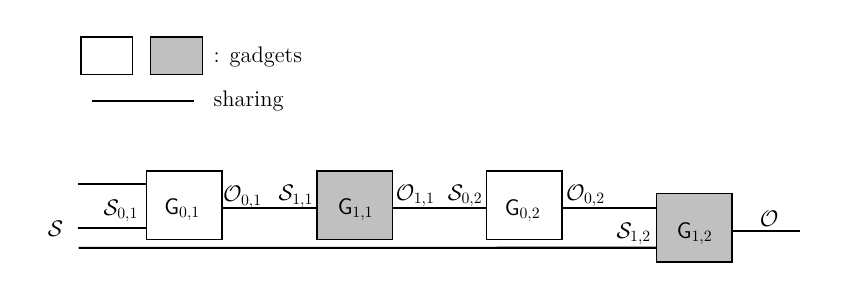
Figure 6: An example illustrating the proof of Theorem